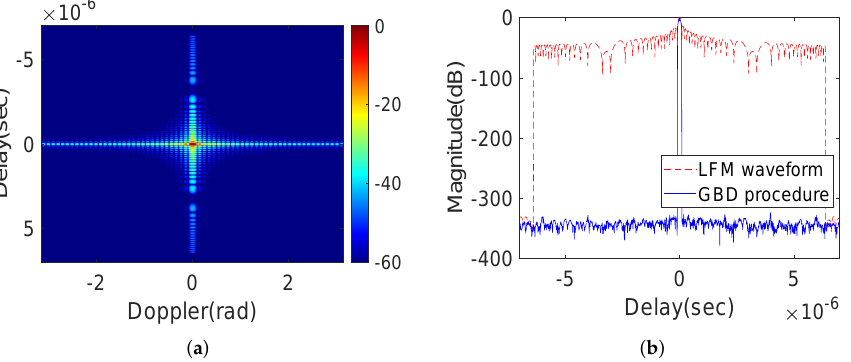
Figure 10. ( a ) The ambiguity functions of LFM waveform (the unit of colorbar is dB); ( b ) zero-Doppler slice comparison with GBD